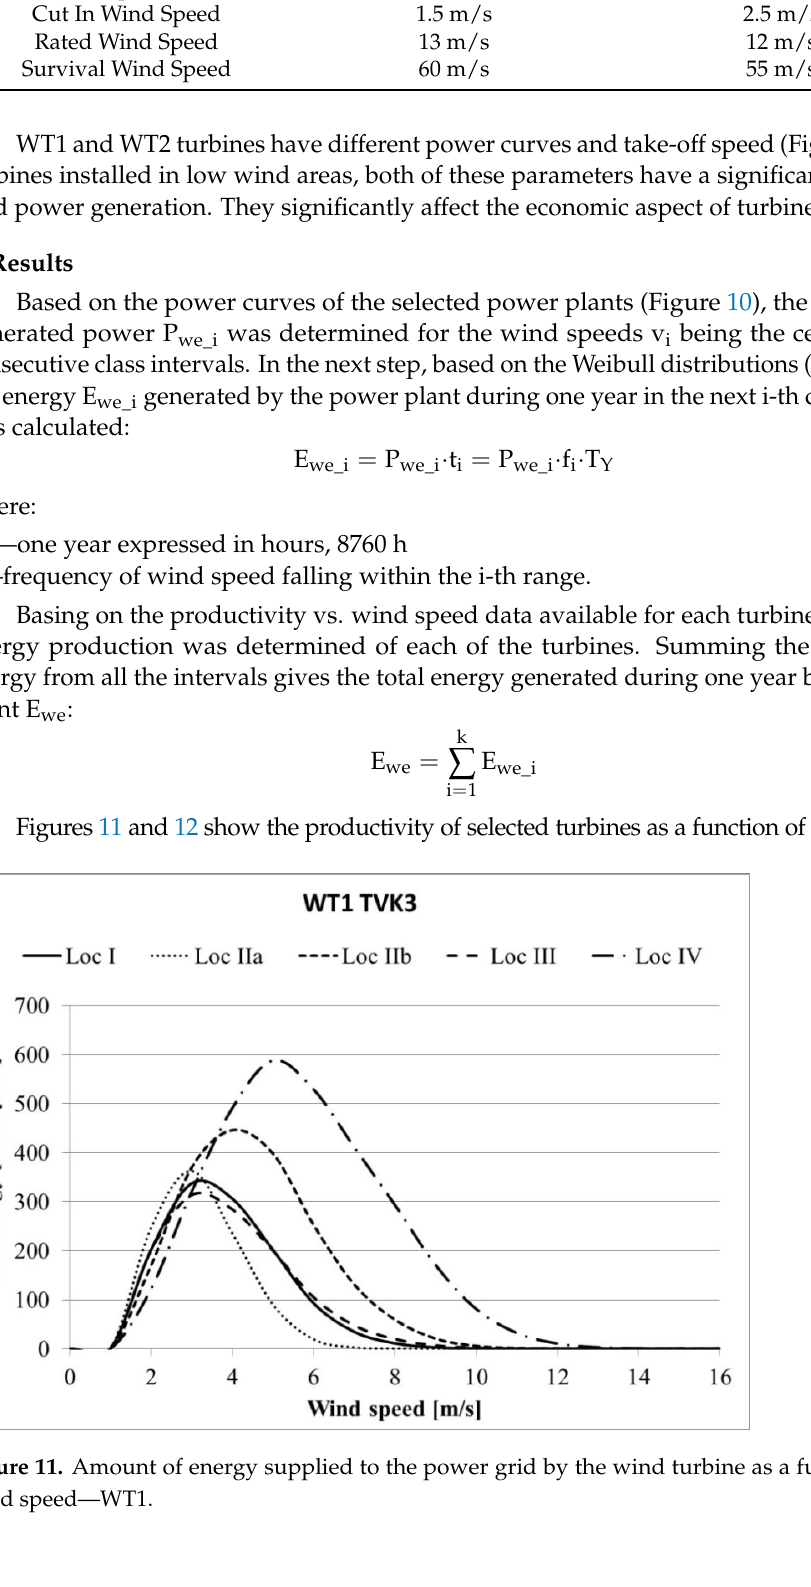
Figure 12. Amount of energy supplied to the power grid by the wind turbine as a function of the wind speed—WT2. Figures 13 and 14 graphically show the amount of grid energy E_we produced by WT1 and WT2 turbines at a given location during the year. The numerical results are